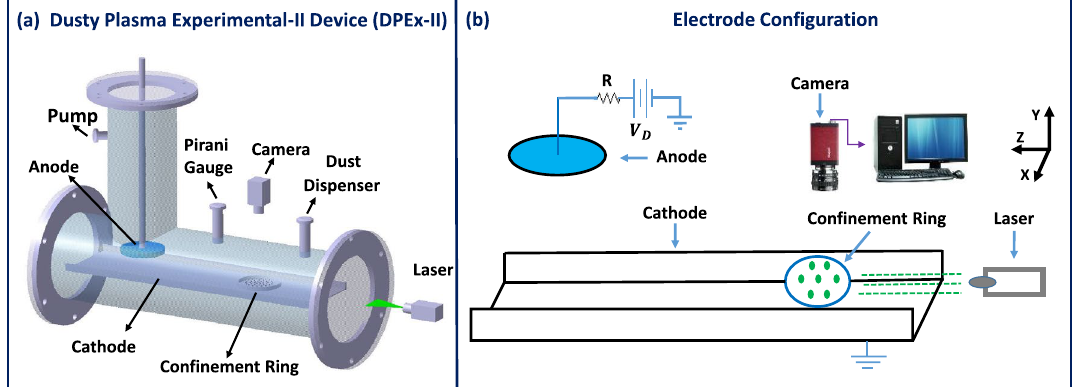
Figure 1. Schematic diagram of the ( a ) DPEx device and ( b ) electrode configuration with diagnostic